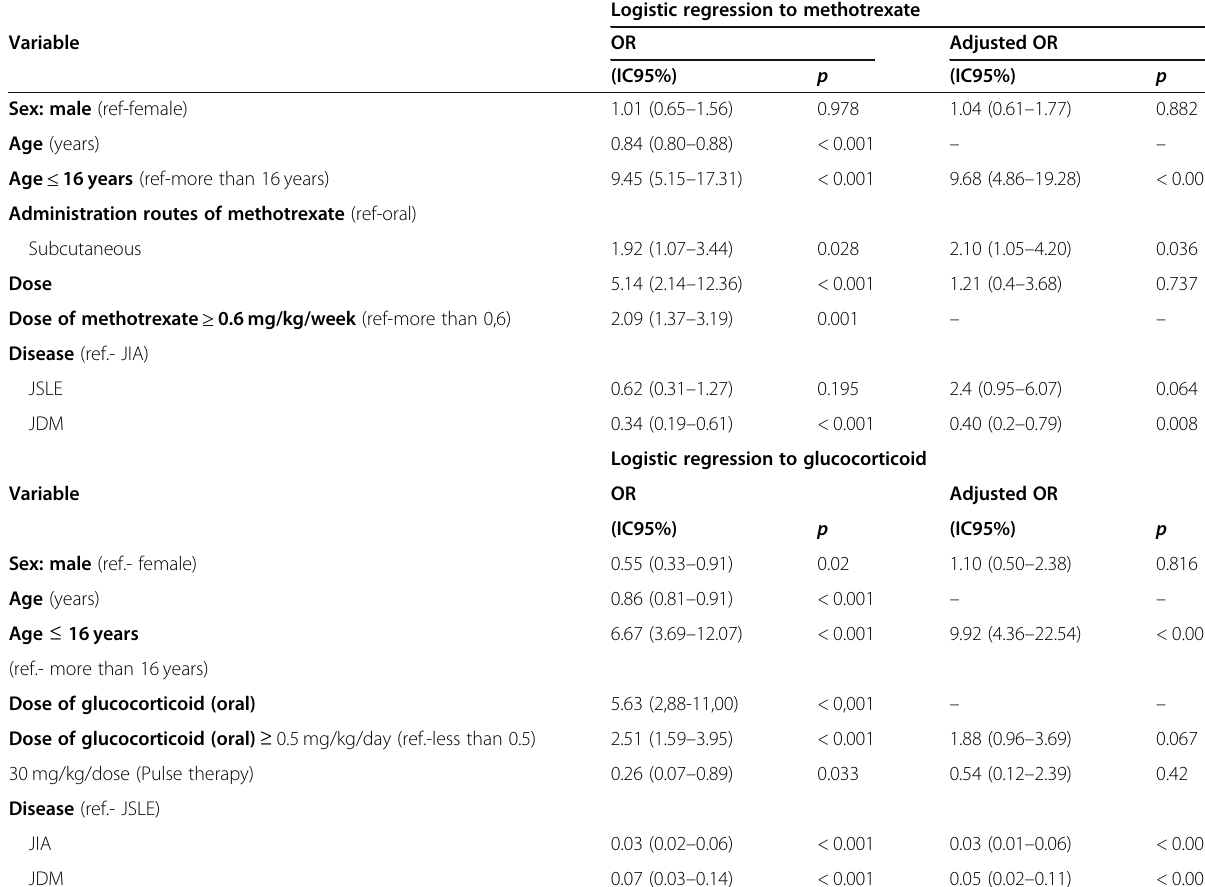
Table 5 Risk of ADRs in response to methotrexate (MTX) and glucocorticoids (GCs) based on logistic regression Logistic regression to